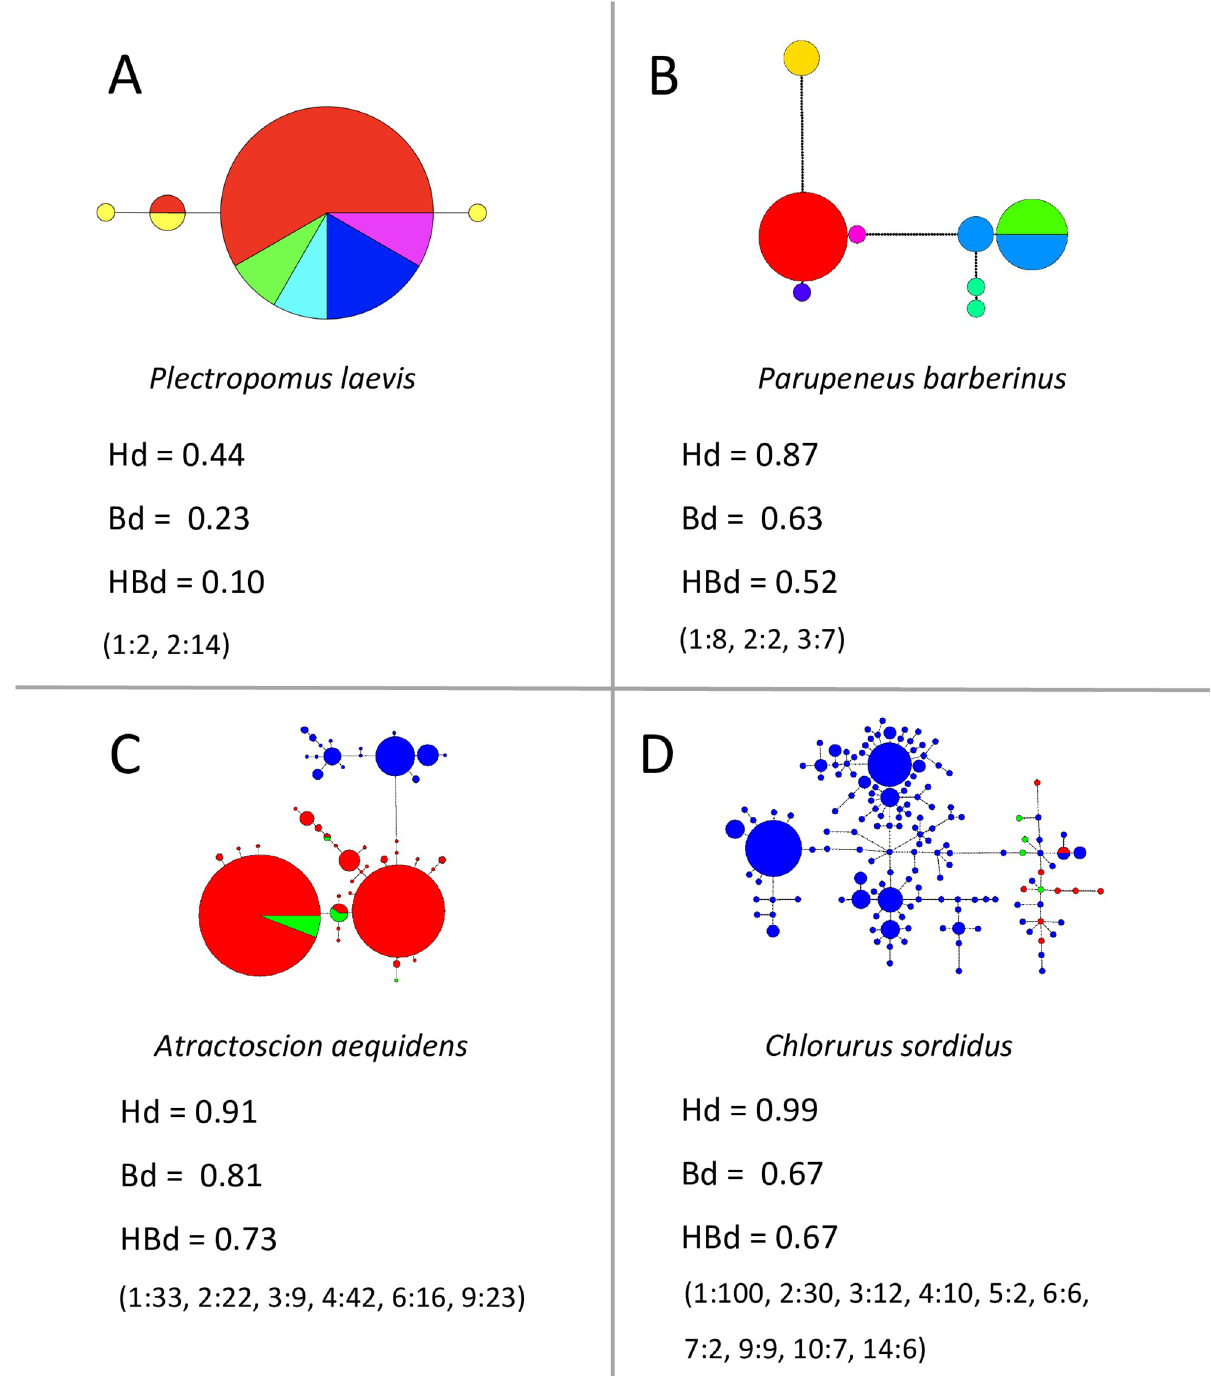
Fig 2. Haplotype networks and diversity indices for published sequence datasets. Colors represent sampled populations. All datasets (described in the Methods section) are based on CO1 or d-loop sequences of fish species shown in italics and were chosen to represent real scenarios with different levels of network complexity (A and B [26]; C [25]; and D [24]). Values for haplotype diversity ( Hd ), branch diversity ( Bd ) and haplotype network branch diversity ( HBd ) are given for each haplotype network. Similar to Fig 1, haplotype classes ( Hc ) are represented in parenthesis with pairs of numbers where the class’ number of branches ( nbHc ) and individuals ( niHc ) are presented to the left and right of a colon, respectively. Additional values referring to these networks are given in Table 1. Sequence and site files for all panels can be found in (S14–S21 Files).